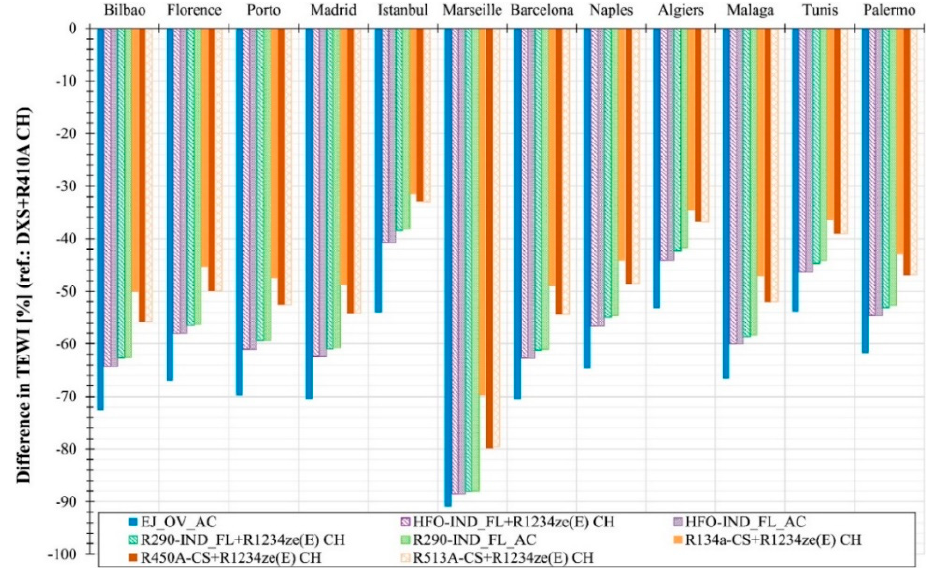
Figure 25. Difference in TEWI among various supermarket refrigeration solutions (DXS+R410A CH: R404A unit+R410A chiller; EJ_OV_AC: multi-ejector based system; -IND+R1234ze(E) CH: indirect arrangements+R1234ze(E) chiller; -CS+R1234ze(E) CH: cascade arrangements+R1234ze(E) chiller) in several locations positioned below the CO 2 equator ( t MT = -4/-10 °C, t LT = -27/-35 °C, t AC = +3/+5 °C, 𝑄(cid:4662) (cid:3014)(cid:3021) = 120 kW, 𝑄(cid:4662) (cid:3013)(cid:3021) = 25 kW, 𝑄(cid:4662) (cid:3002)(cid:3004) = 120 kW) [52].